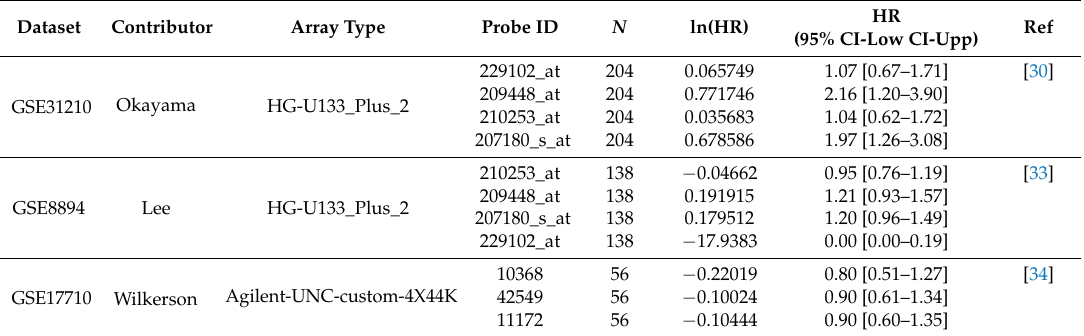
Table 1. Association of TIP30 expression and relapse-free survival in lung cancer patients from the PrognoScan